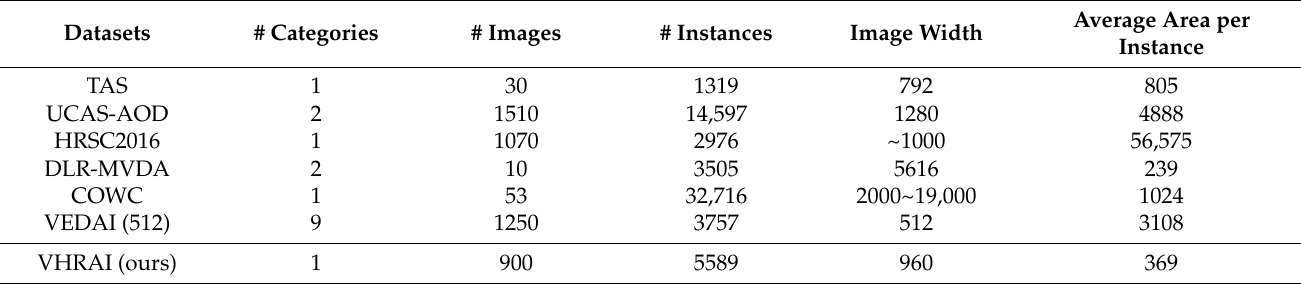
training set. ‘#’ represents the meaning of ‘the number